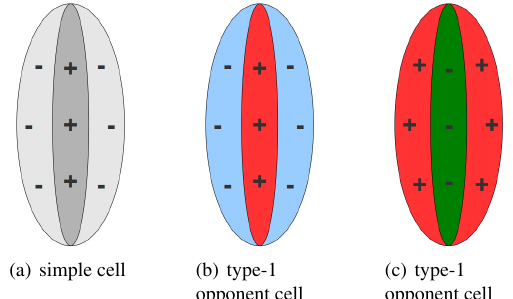
Figure 2: Illustration of receptive fields of cells within the visual